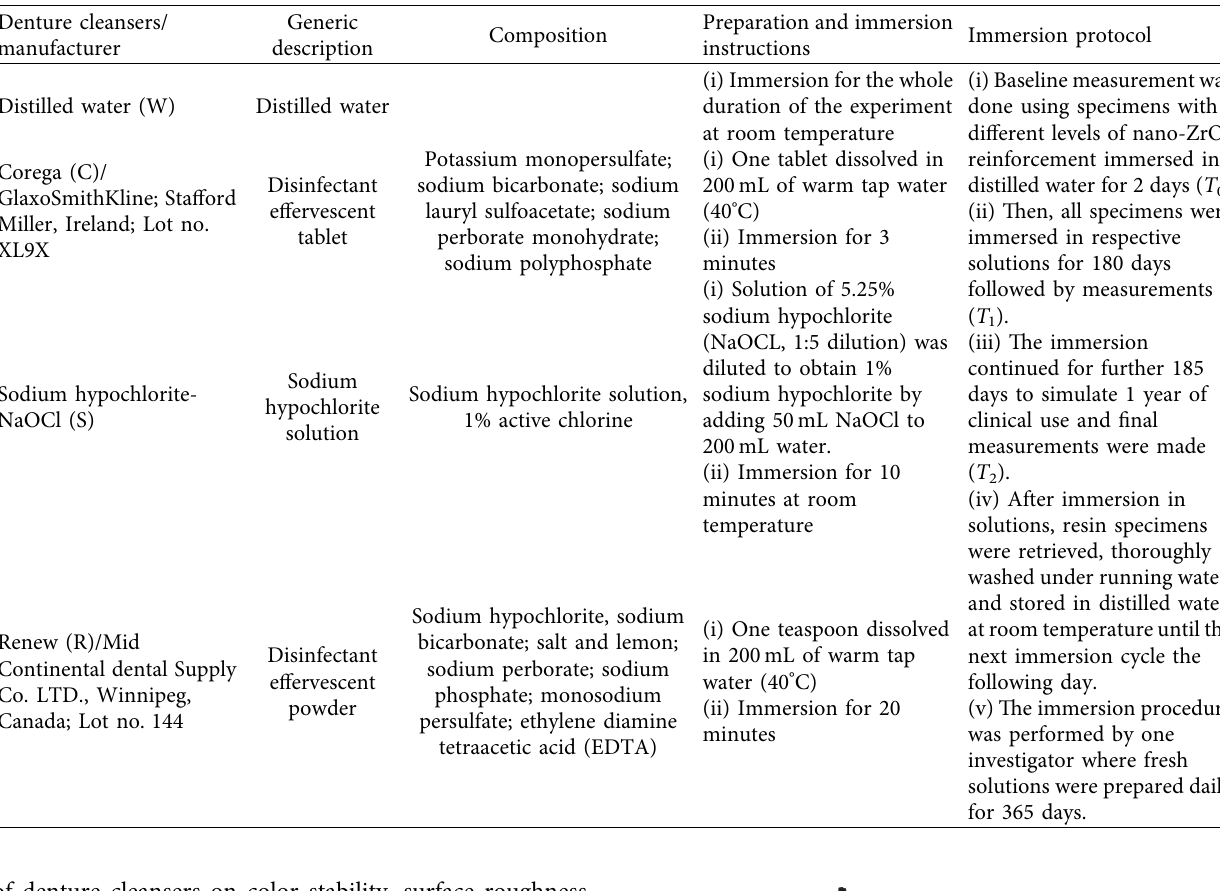
Table 1: Cleansing agents, composition, and preparation as recommended by the manufacturer and immersion protocol.